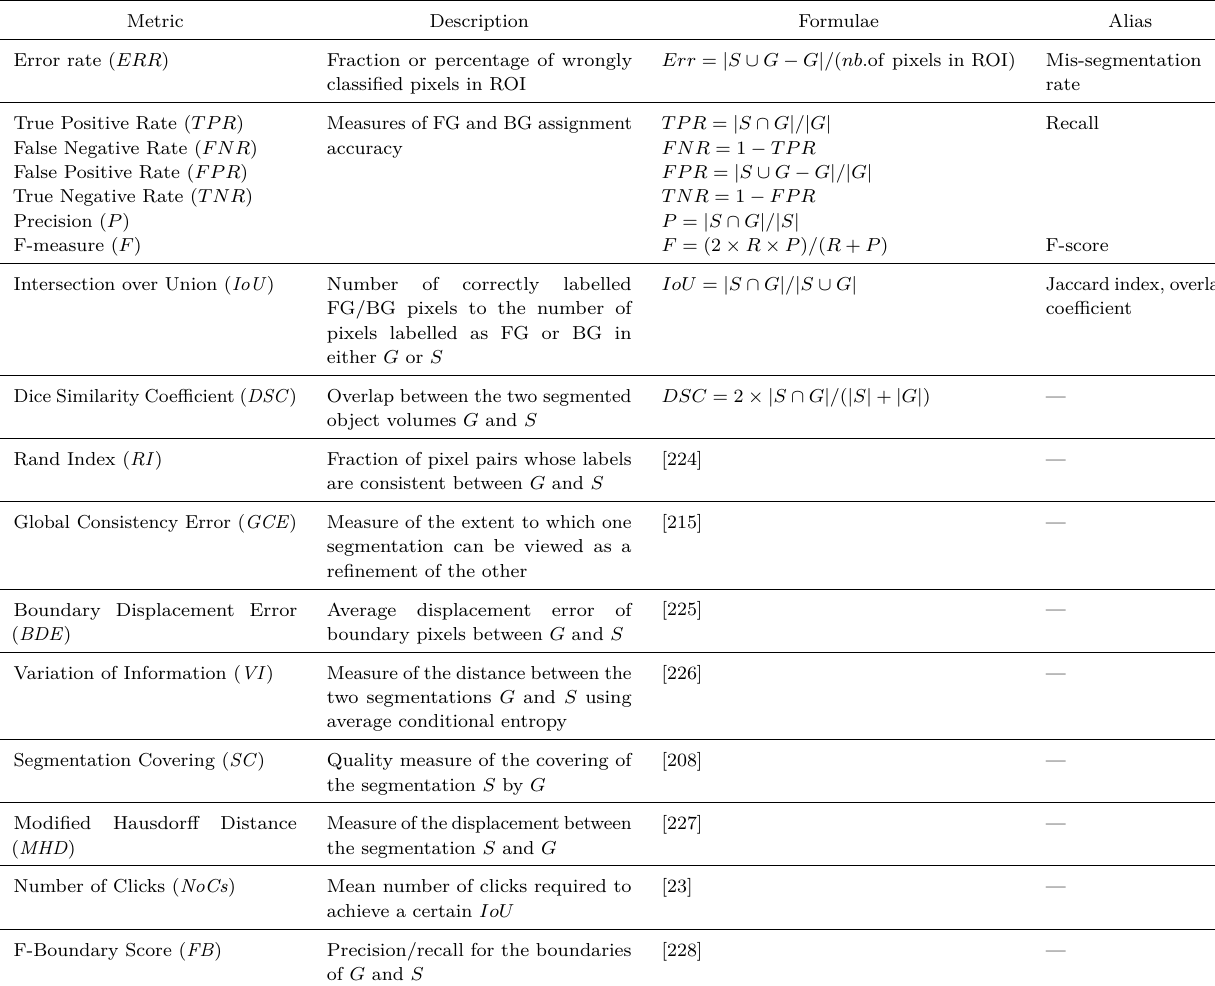
Table 2 Different measures used in the literature to evaluate IIS